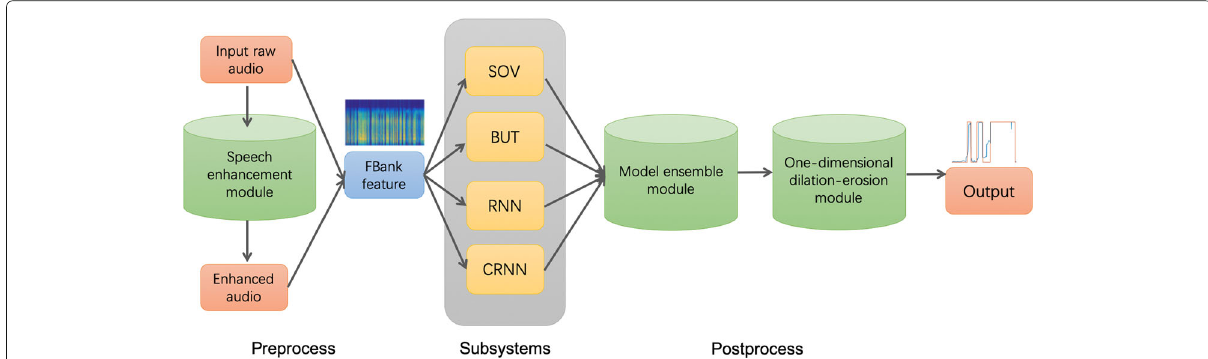
Fig. 1 Overview of our SAD architecture used in